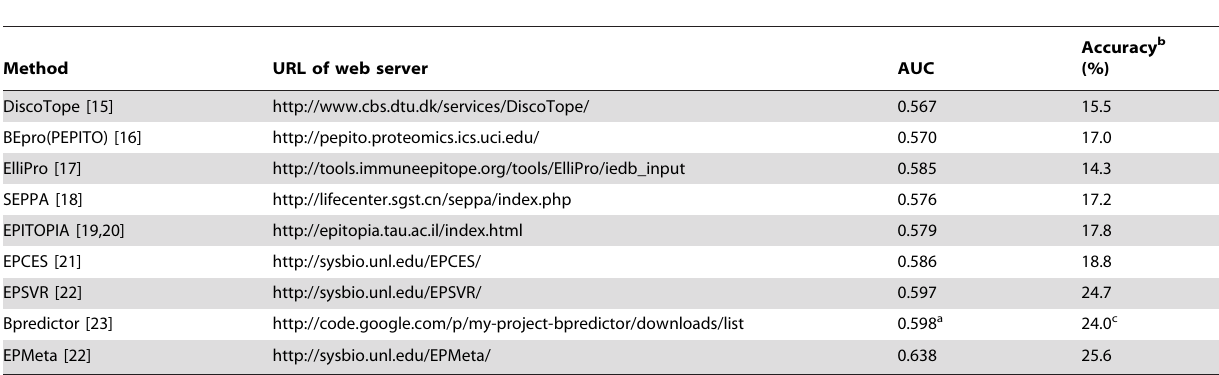
Table 1. List of the conformational B-cell epitope prediction methods and their obtained AUC results.